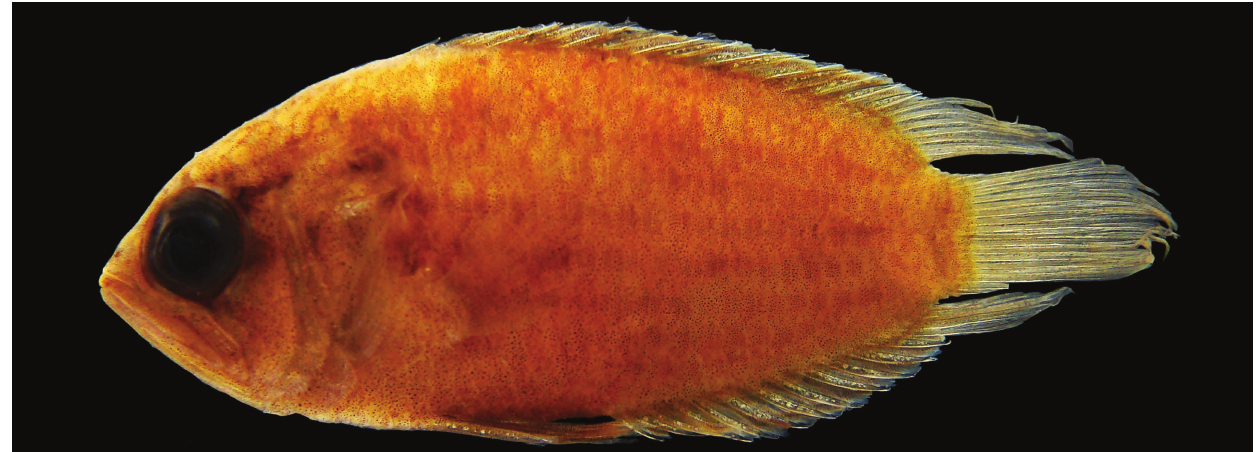
Fig. 1 . Polycentrus jundia , new species, holotype, MZUSP 54586, 28.3 mm SL, Brazil, Amazonas State. Left lateral view. absence); subocular band being shorter than orbital diameter Diagnosis. Polycentrus jundia is distinguished from P. (Fig. 2A) ( vs . length of subocular band equal to or greater schomburgkii by: diagonal upper postorbital band being than orbital diameter (Fig. 2B)); snout blunt ( vs . protruding); shorter than orbital diameter (Fig. 2A) vs . longer (Fig. 2B); mouth isognathous ( vs. prognathous); serrations absent presence of the median postorbital horizontal band ( vs.